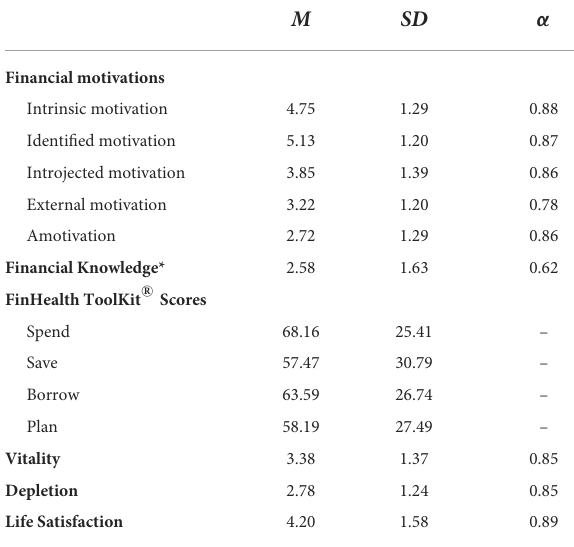
TABLE 7 Study 2 means, standard deviations, and internal reliabilities for study